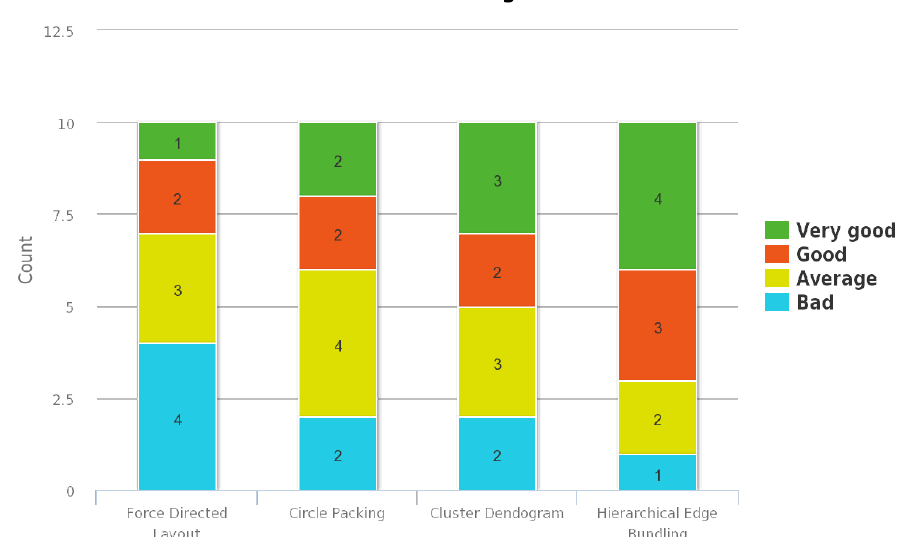
Figure 1. Stacked bar chart representing the distribution of User Rating for all the